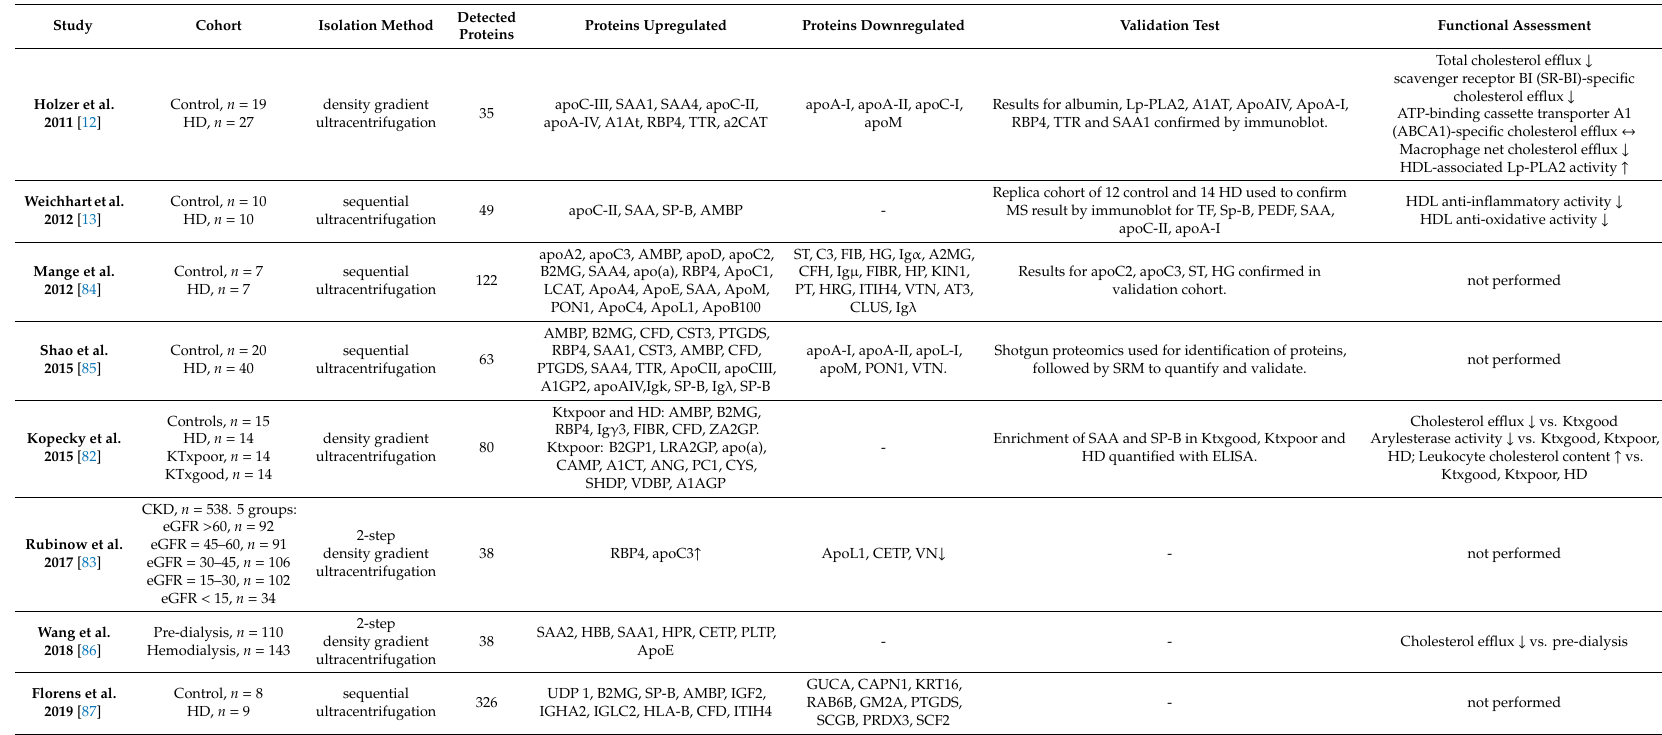
Table 3. Summary of studies investigating the HDL proteome in chronic kidney